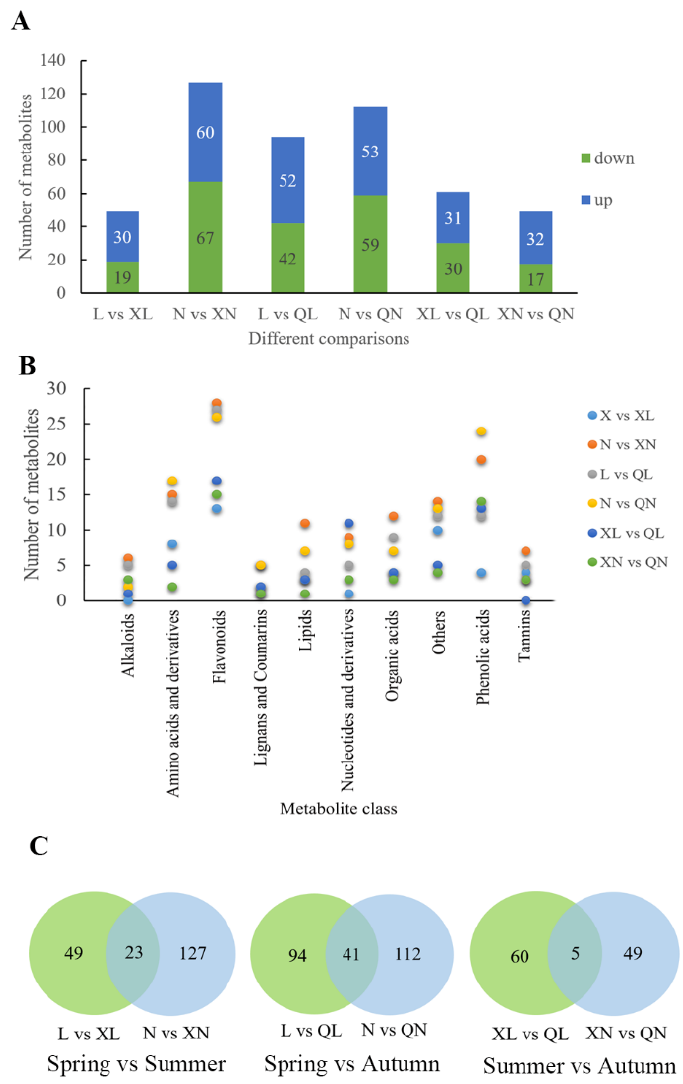
Figure 4. Differential metabolites identified in Changqing tea shoots during different seasons. ( A ), Differential metabolites numbers of Changqing tea shoots in different seasons from two tea gardens. ( B ), Classification of differential metabolites in Changqing tea shoots during different seasons. ( C ), Venn diagram of differential metabolites in Changqing tea shoots during different seasons. N, XN and QN mean samples from Nanhuyulu tea garden in spring, summer, and autumn, respectively. L, XL and QL mean samples from Litaishan tea garden in spring, summer, and autumn, respectively. Comparing summer to autumn, for flavonoids, only